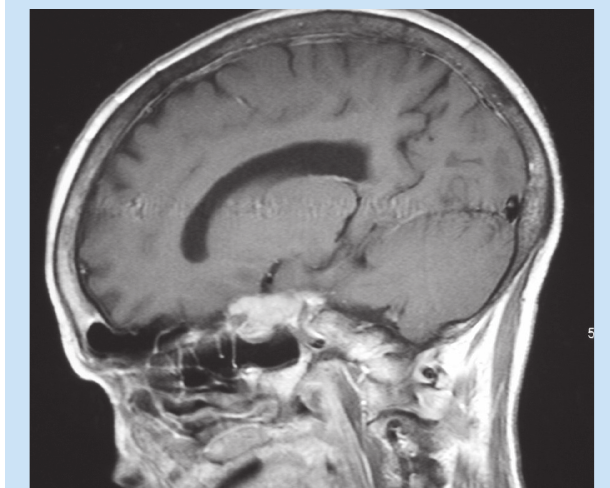
Fig. 3. T1W gadolinium-enhanced MRI shows enhancing right parasellar mass.